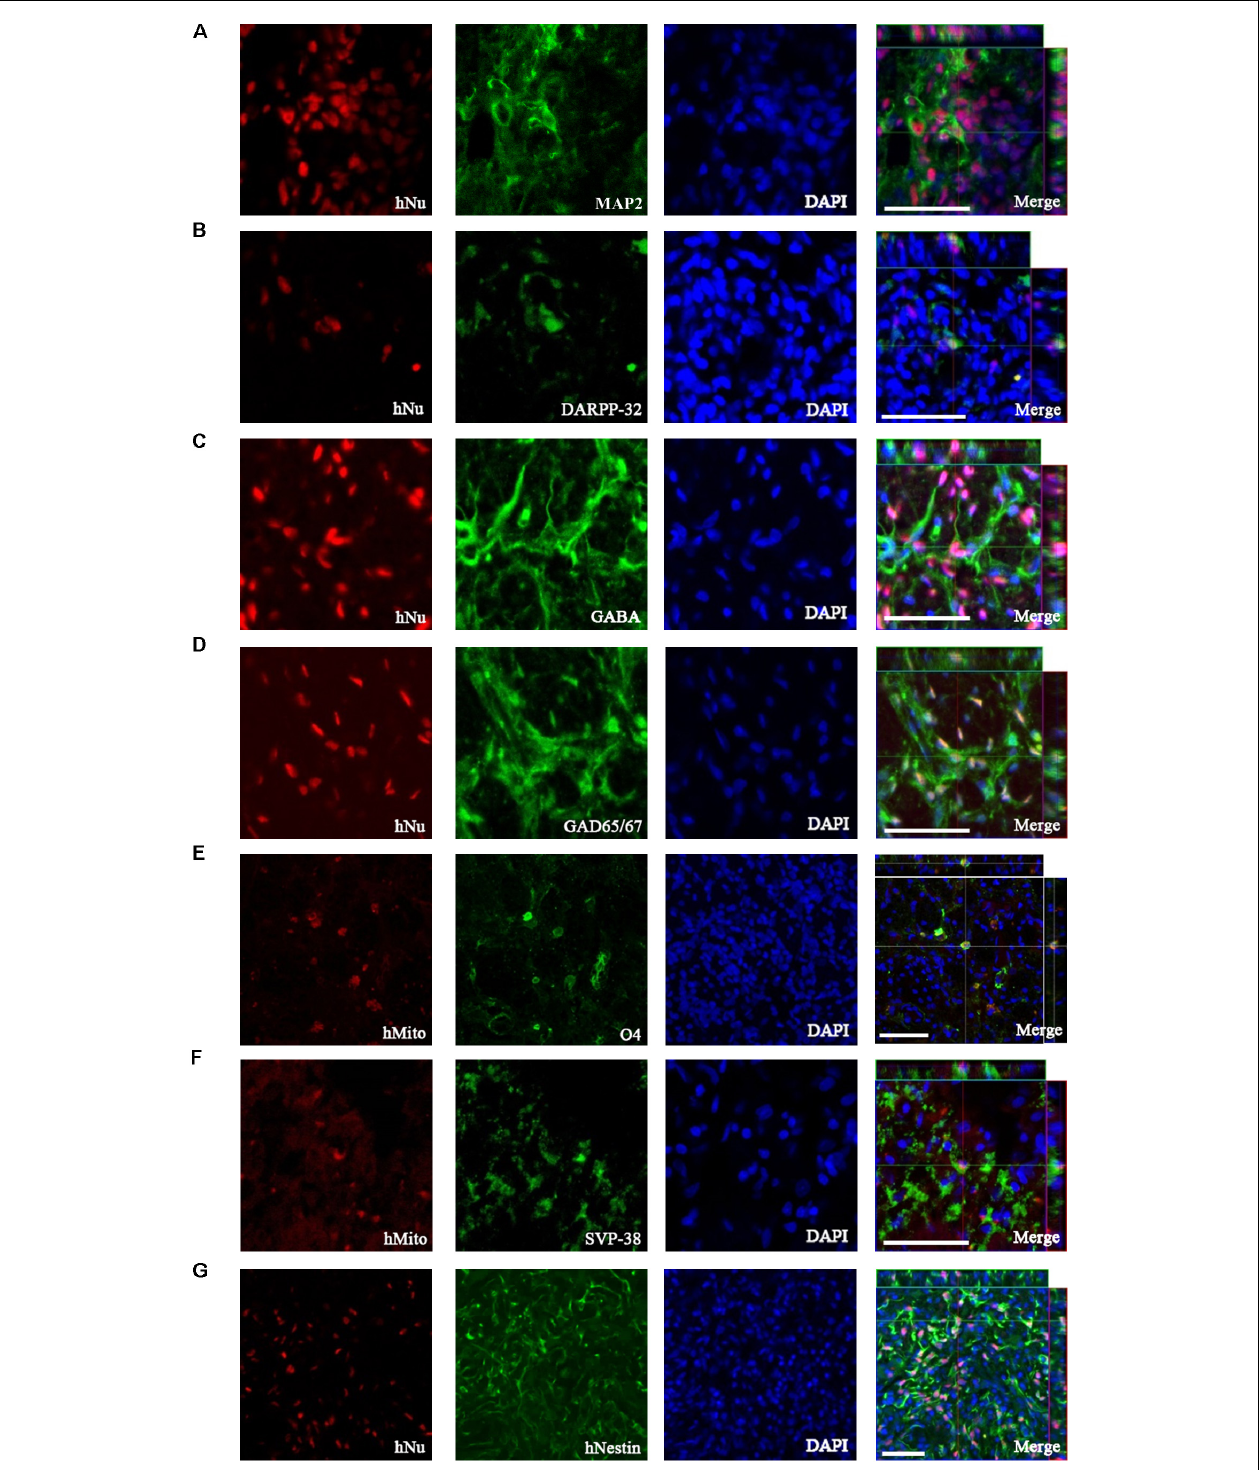
FIGURE 3 | IHC analysis showing the neuronal differentiation caused by transplanted 1231A3-NPCs. Antibodies against either hNu or hMito show the transplanted 1231A3-NPCs were co-localized with (A) MAP2, (B) DARPP-32, (C) GABA, (D) GAD65/67, (E) O4, (F) SVP-38, and (G) hNestin antigens. Scale bar = 50 µ m. IHC, immunohistochemical; NPCs, neural precursor cells; DAPI, 4 (cid:48) ,6-diamidine-2-phenylindole dihydrochloride; GABA, gamma-aminobutyric acid; GAD, glutamic acid decarboxylase; hMito, human-specific mitochondria; hNu, human-specific nuclei antigen; MAP2, microtubule-associated protein; SVP-38, synaptophysin.